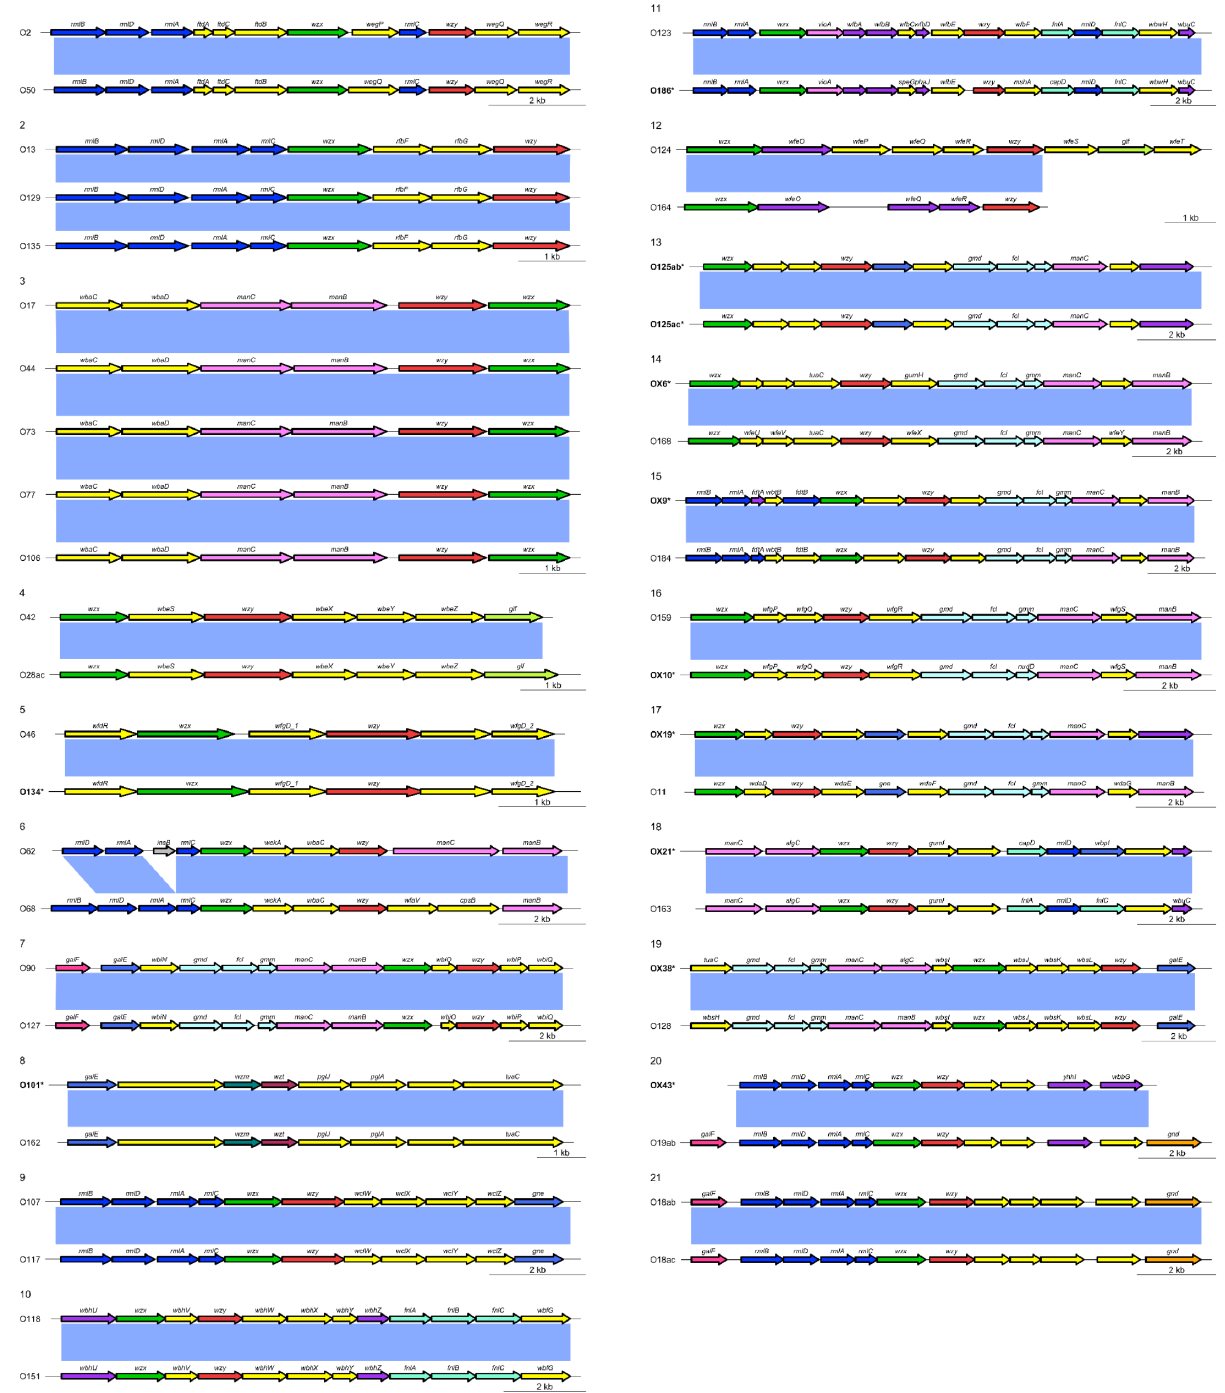
Fig 2. Comparison of identical